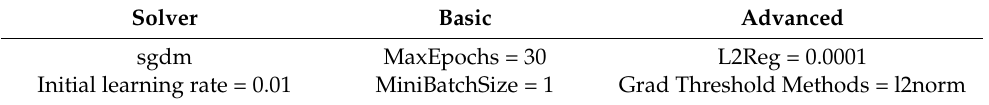
Table 2. Pre-trained CNN training